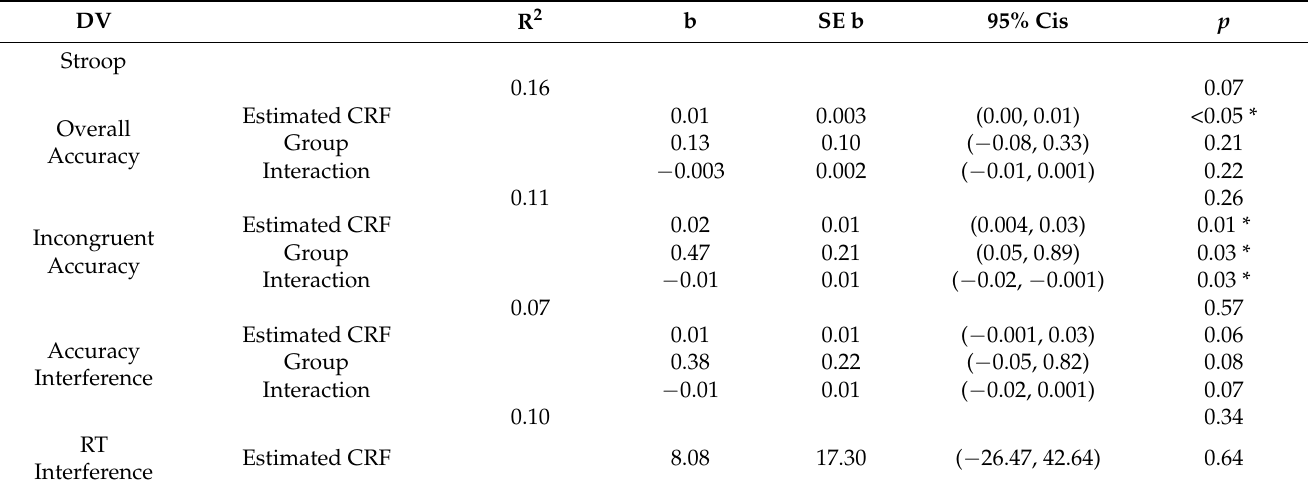
Figure 1. ( A ) The moderating effect of group (ADHD vs. Control) on the relationship between estimated CRF and Stroop incongruent accuracy. Bars reflect standard error. * p < 0.05 ( B ) Scatterplot of raw data included in the mediation analysis. Regression lines reflect the mediation output (solid grey line = ADHD; dashed black line = Control). Table 3. Regression coefficients of the moderating effect of group (ADHD vs. Control) on estimated CRF and cognitive